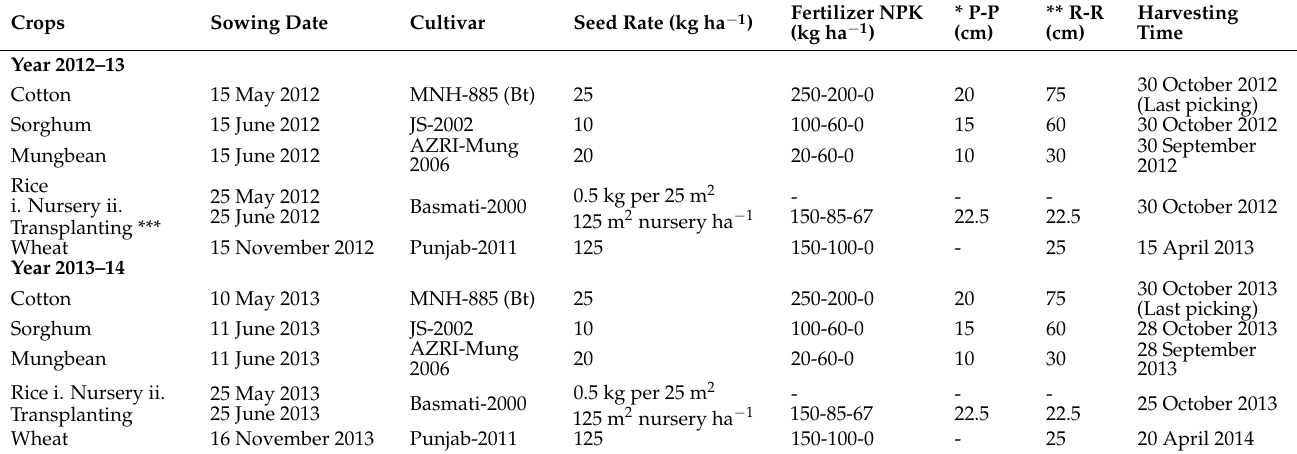
Table 3. Details of crop management practices used, for different crops, in the